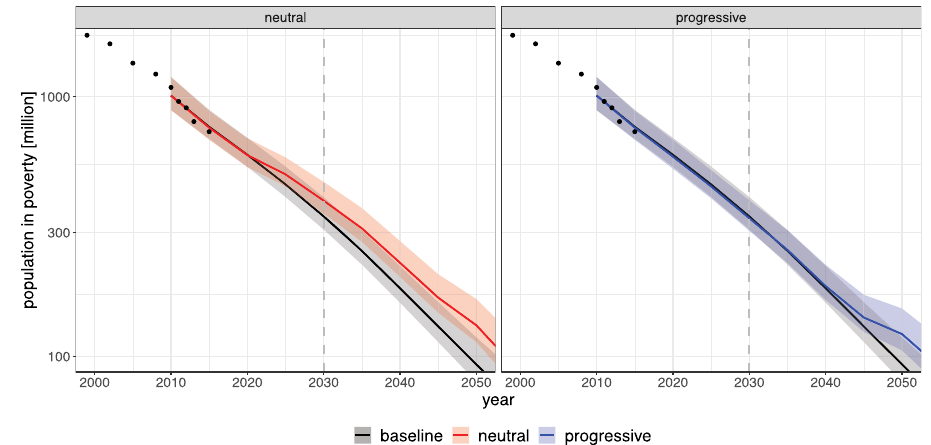
Fig. 3 Global poverty headcounts under ambitious climate policy (SSP2). We show here our projections for the global number of people below the absolute poverty threshold of 1.90 $/day (note the logarithmic scale). The SSP2 baseline (black line) is identical to Fig. 1. For the climate policy scenario the poverty outcomes depend substantially on how the carbon pricing revenue is used (coloured lines) — leading either to a slowdown of poverty reduction or to a trend comparable to the baseline. The solid line represents the central projection of our model; the shaded bands are the 68% prediction intervals (see also caption of Fig.